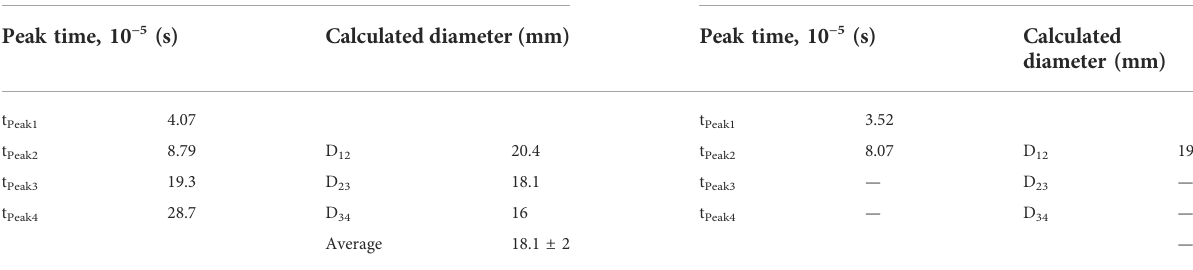
Uncertainty on the average is represented with 1